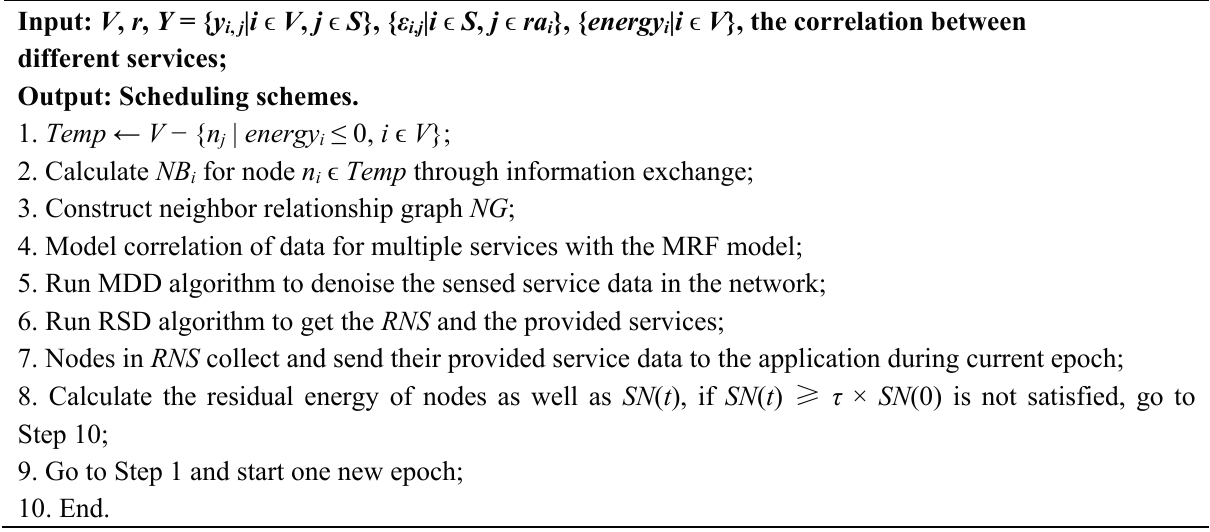
Algorithm 3. MRF-based Multi-service Node Scheduling (MMNS)